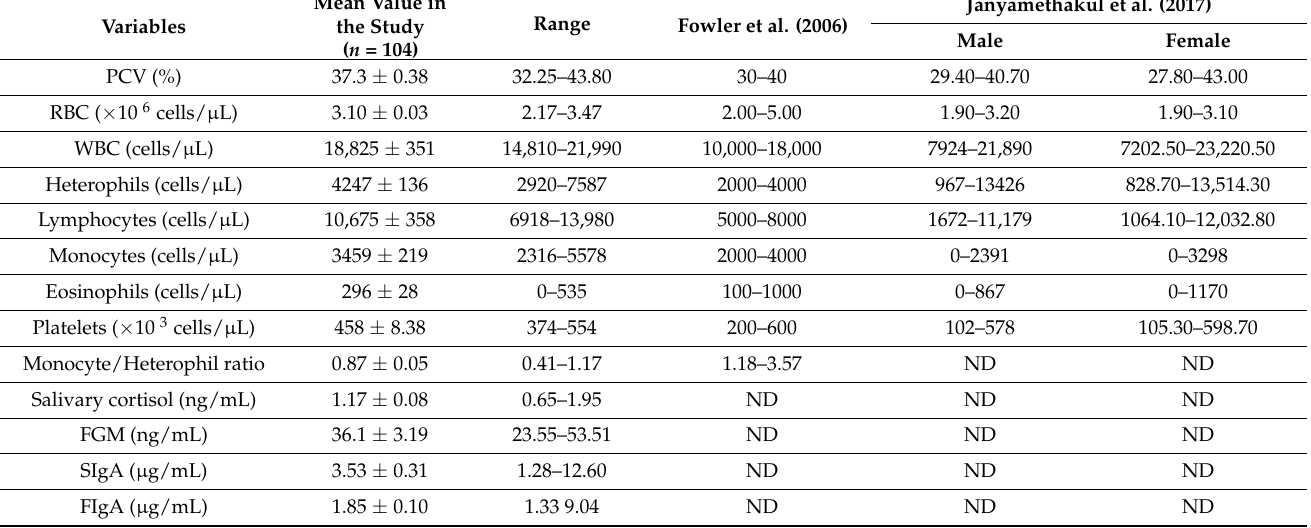
Table 4. Mean ( ± SEM) hematology values and stress indicator concentrations in eight young calves without clinical illness throughout the study period, excluding E5 that developed EEHV-HD and died during the